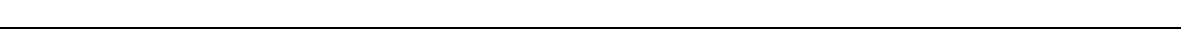
Fig. 2 Centriole ampli fi cation is widespread in cancer cells. a Immuno fl uorescence images of cell lines without (upper panel) and with (lower panel) centriole ampli fi cation. Cells were stained with DAPI (blue), centrin (green), α -tubulin (red) and CP110 antibodies (red-insets). Scale bar 5 µ m, insets 1 µ m. Note the presence of centrin dots lacking CP110 staining in the SN12C cell line (upper panel-inset 1). b Output of the secondary immuno fl uorescence screenings for centriole number in the NCI-60 panel. To validate the primary screening, the top 50% of ampli fi cation and a subset of less-defective ones from the primary screening were incorporated in the secondary screening (see text). The results of the secondary screening are depicted in the bar graph in which cell lines were ranked according to their percentage of mitotic cells with more than four centrioles. To de fi ne the cut-off for centriole ampli fi cation and the variability of centriole number in non-cancerous cell lines, we quanti fi ed centriole number in fi ve non-cancerous cell lines (depicted in green): RPE-1 (retinal pigmented epithelial cells), HB2 (mammary luminal epithelial cells), HaCat (keratinocytes), LT97 (colon adenoma cells) and SAEC (small airway epithelial cells). The average percentage of cells with centriole ampli fi cation in the non-cancerous cell lines is 7 ± 3%, therefore we set the cut-off for centriole ampli fi cation to 13% (average + 2 standard deviations). 28 cell lines from the NCI-60 panel displayed signi fi cant centriole ampli fi cation. Note that for most of the cell lines, the majority of cells with ampli fi cation showed 5 to 8 centrioles per cell (grey). Cells with more than eight centrioles per cell (red) were less commonly observed. A total of 50 to 60 mitotic cells were analysed per cell line. BR breast, CNS central nervous system, CO colon, BL blood,